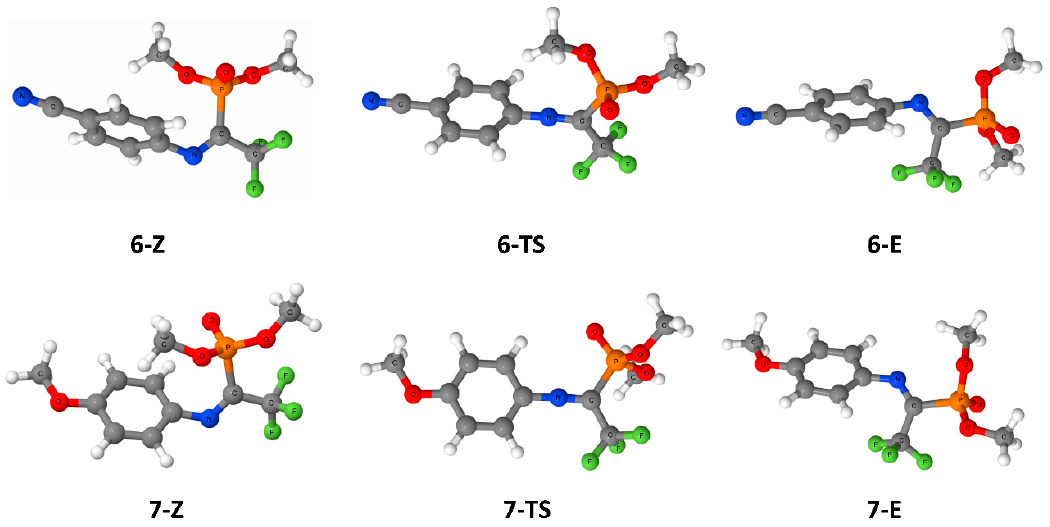
Figure 9. Optimized structures of the Z- and E-isomers of compound 5 ( 5-Z , 5 ′ -Z and 5-E , 5 ′ -E , respectively), and the structures corresponding to the transition states of the isomerization reaction ( 5-TS and 5 ′ -TS ).